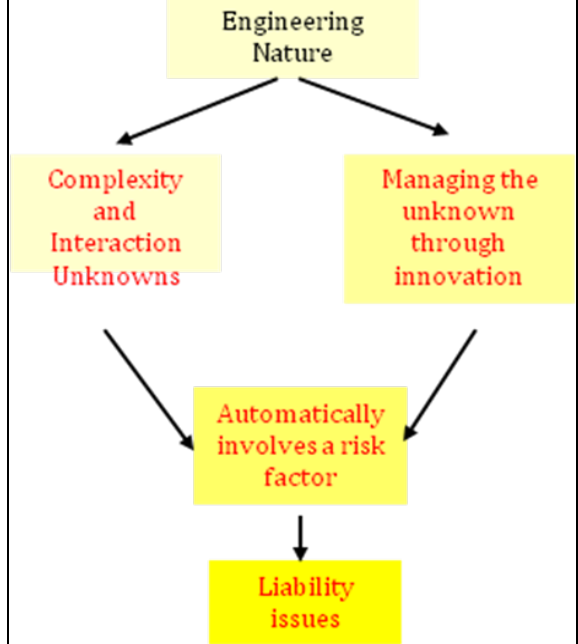
Figure 1. Liabilities associated with the nature of